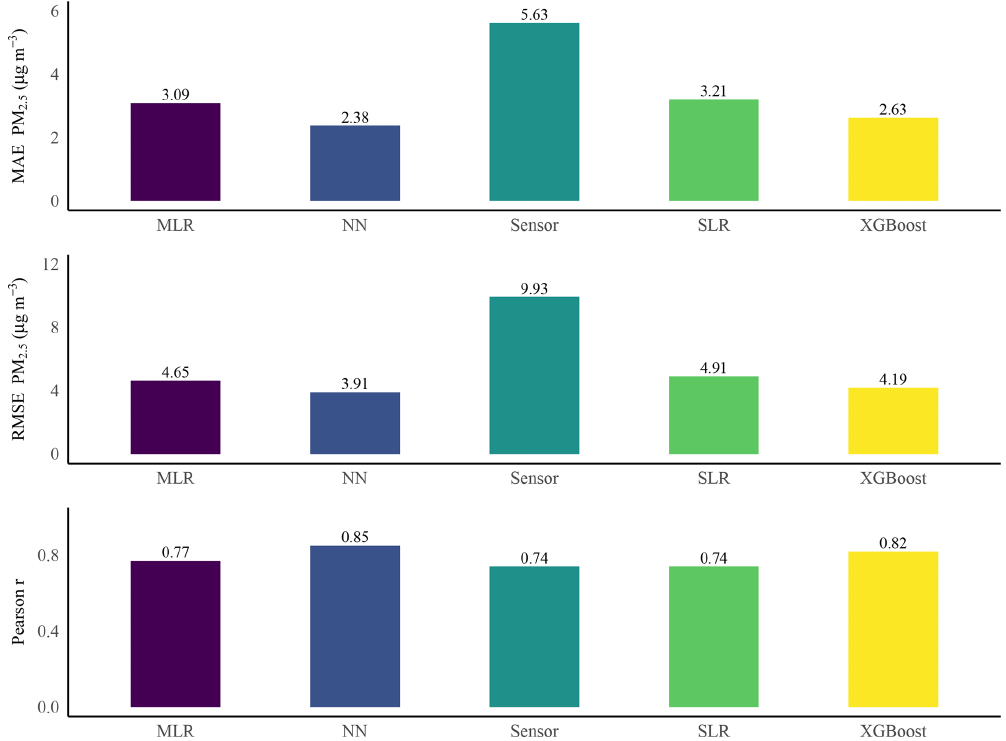
Figure 10. Performances of different calibration methods. Based on 610 test examples. NN: neural network, MLR: multiple linear regression, SLR: simple linear